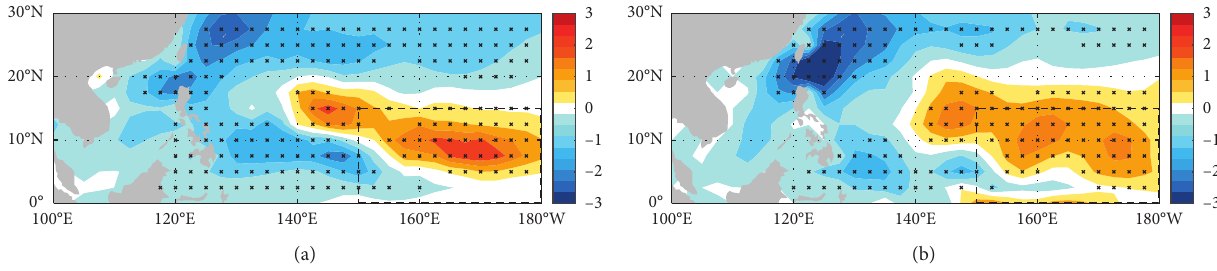
and (b) GPI between subsurface cold and warm years in JASON season (cold-warm). 04 ocean